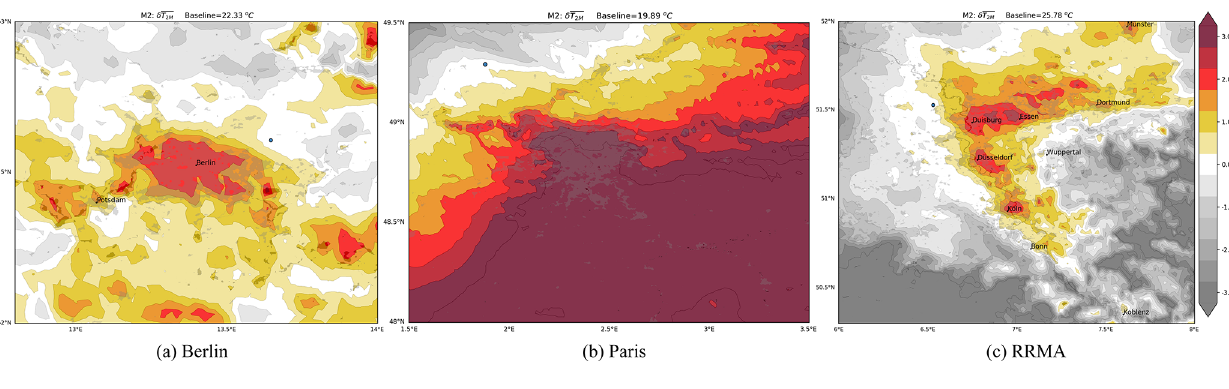
Figure 3. UHI calculated with M2 on the original grid (no interpolation) for Berlin, Paris and the Rhine-Ruhr Metropolitan Area (a–c) . The location of the grid-point used as baseline is shown here as a blue dot, or in Fig. 1 as a blue grid-point